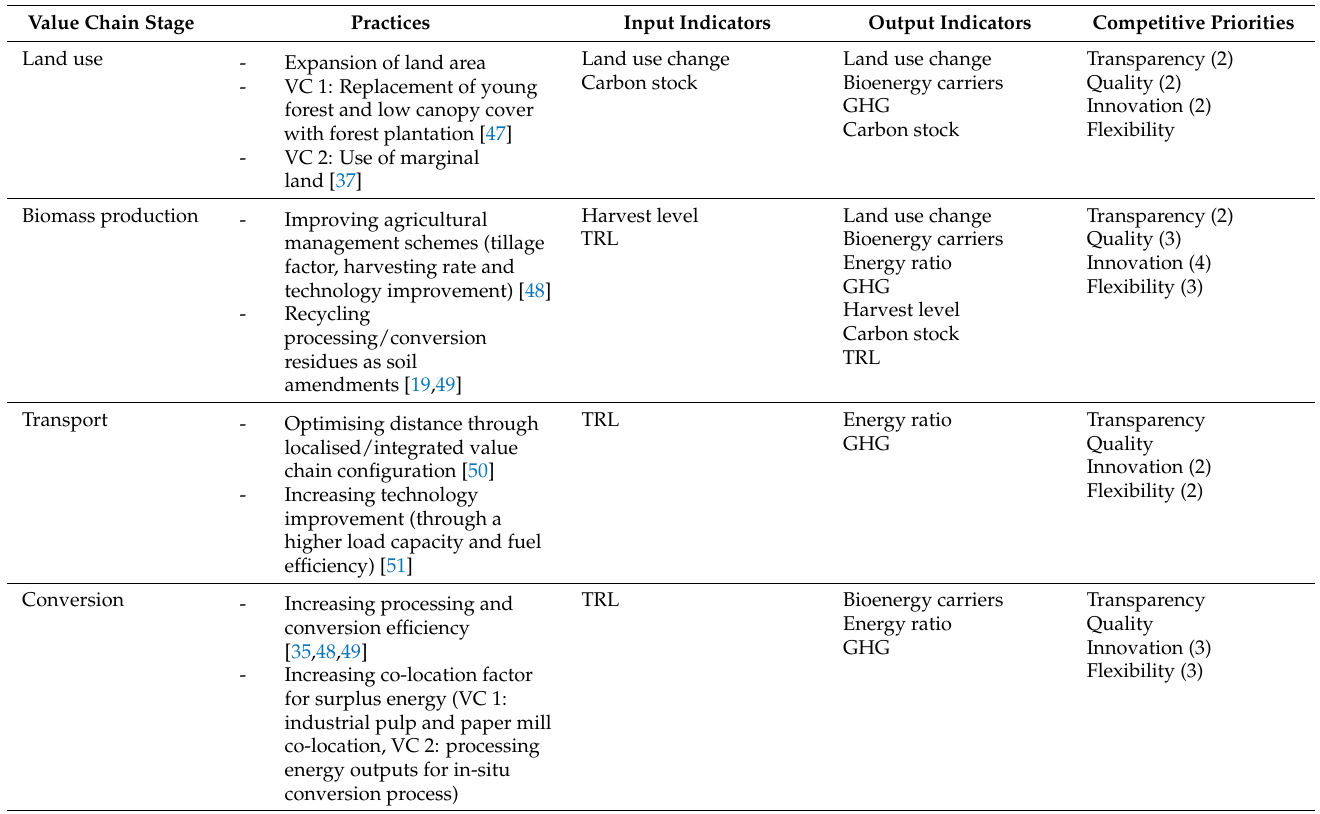
Table 2. Practices evaluated, indicators as model inputs and outputs, and competitive